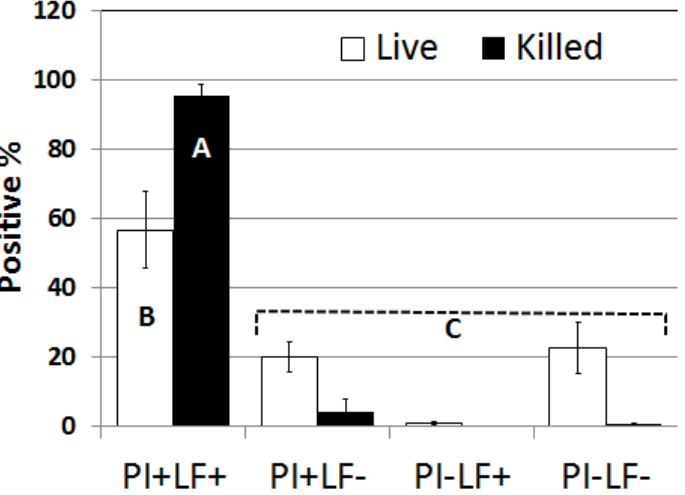
Figure 7. The proportion of untreated (live) or killed (snap-frozen) sperm positive for PI or LF counted from the image captured with the combined visible/fluorescent image seen in Figure 6. Note that almost all killed sperm were PI+ and LF+ (PI+LF+), but untreated sperm had a lower percentage of this category. On the other hand, untreated sperm had more than 20% PI negative that were also LF − (PI − LF − ). Additionally, note that while untreated sperm had about 20% PI+ they were still LF − (PI+LF − ), which may suggest that LF binding to sperm is sequential over time; i.e., as sperm deteriorate more, more LF will bind to them. Different letter (A.B.C) indicates significant differences p < 0.001.